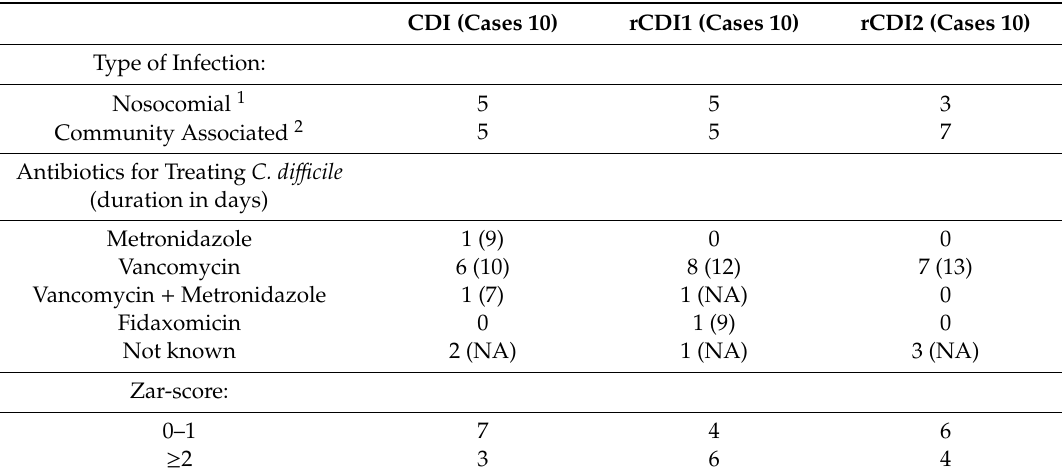
Table 2. Characteristics and treatment of Clostridioides difficile infection in non-refractory and refractory patients. Abbreviations: CDI = patientssufferingfromnon-recurrent C.difficile infection; rCDI1 = patients suffering from recurrent C. difficile infection, first episode; rCDI2 = patients suffering from recurrent C. difficile infection, second episode.